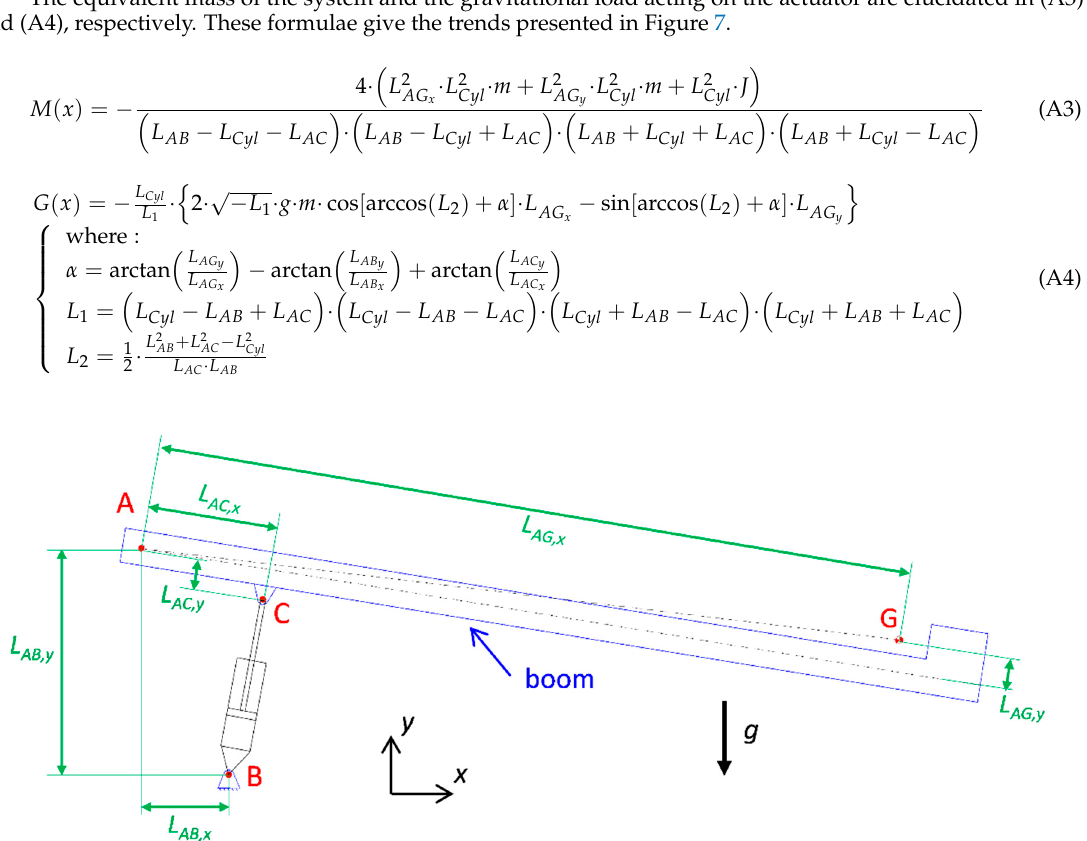
Figure A1. Kinematics of the single-boom crane used for the experimental Figure 17. Kinematics of the single-boom crane used for the experimental testing.